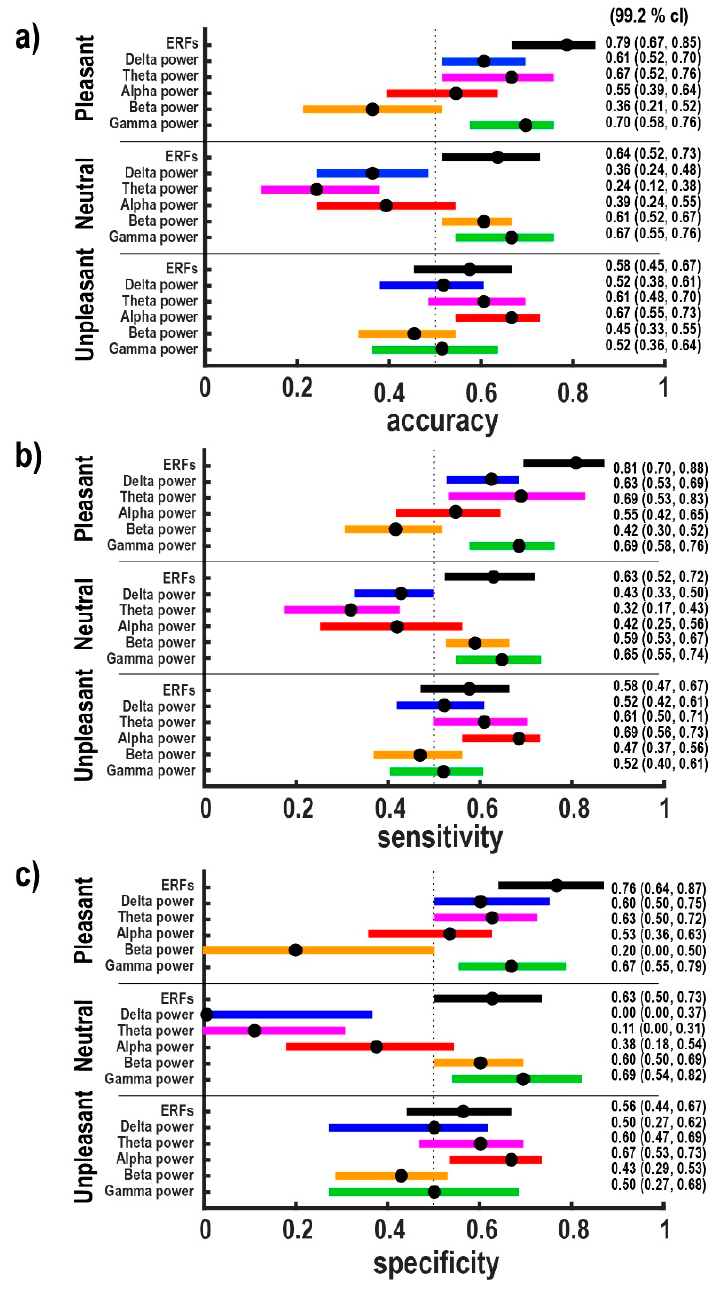
Figure 2. Evaluation of classifier performance for all feature sets based on 1000 16-fold-stratified cross- validations. Numerical values represent medians as well as 95% simultaneous confidence intervals